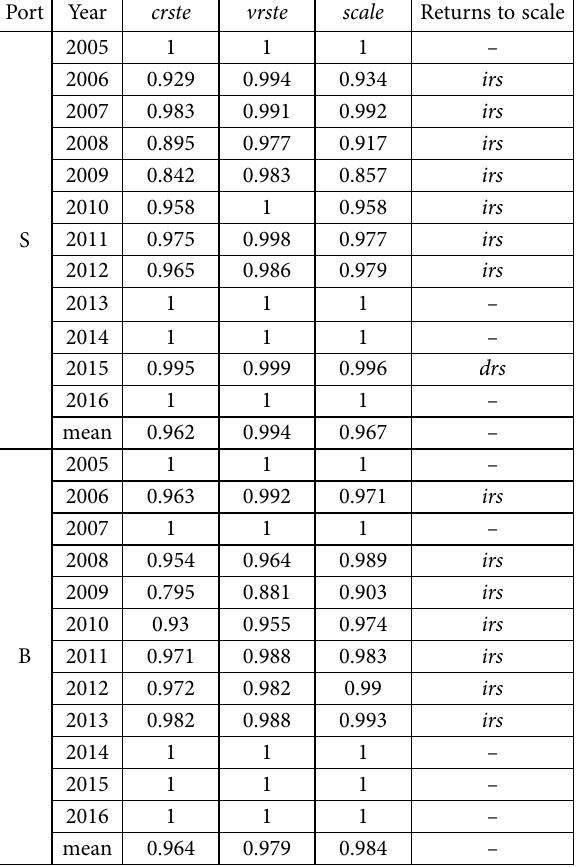
Table 1. Results of the first stage